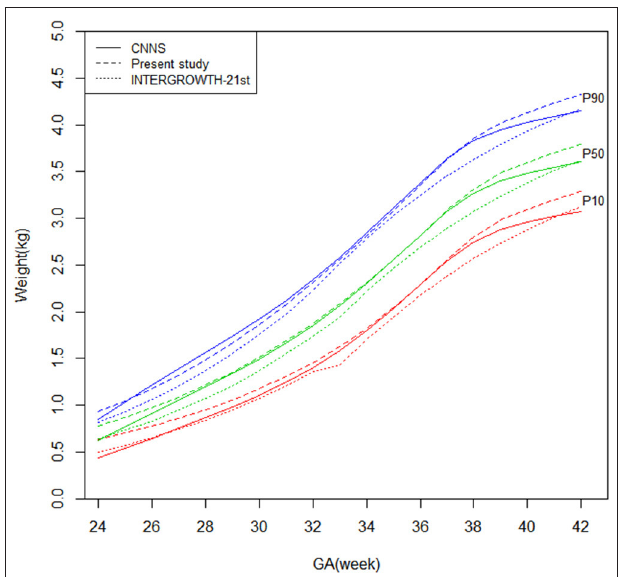
FIGURE 1 | Comparison of birthweight (kg) curves by gestational age among the present study, CNNS and INTERGROWTH-21st Newborns Size Standards/ References